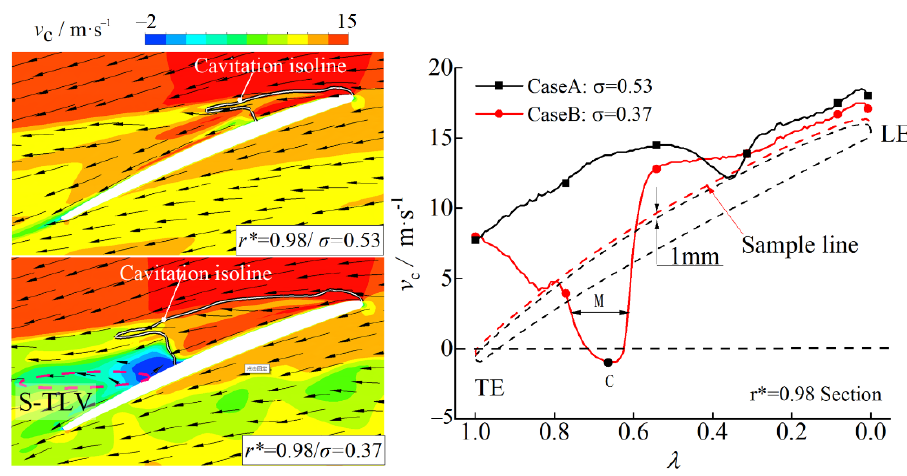
Figure 12. Circumferential velocity distributions and low velocity zone M.